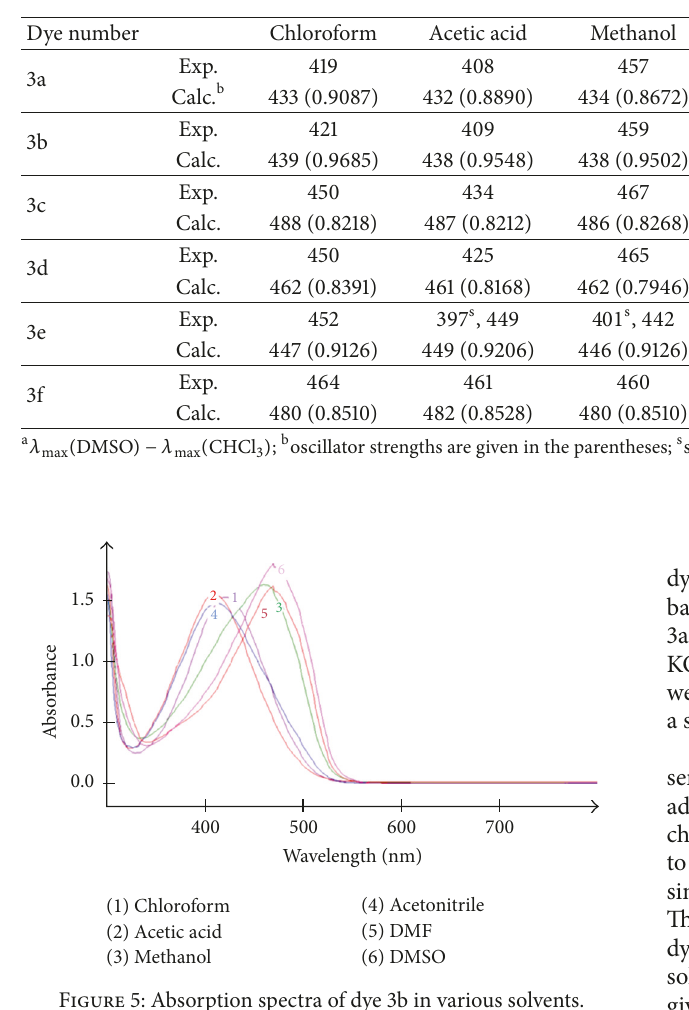
Table 3: Influence of solvent on 𝜆 max (nm) of dyes 3a–3f.